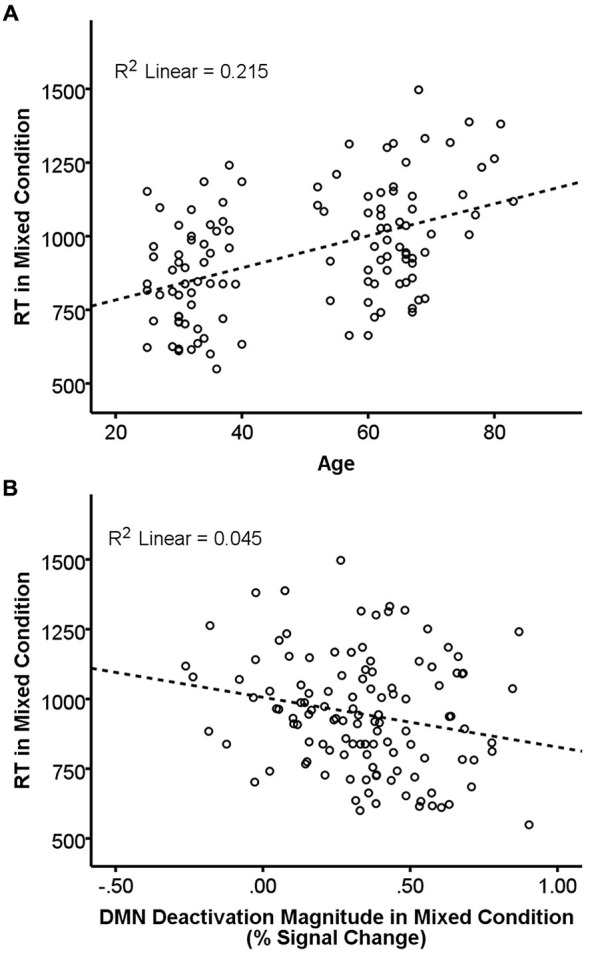
Relationship of age and DMN deactivation magnitude with REACTION TIME (RT) in the mixed condition. RT in the mixed condition was positively correlated with age (A) and negatively correlated with deactivation magnitude (B). Dashed lines are the linear best-fit line. R2 is the portion of the total variance explained by the regression line.